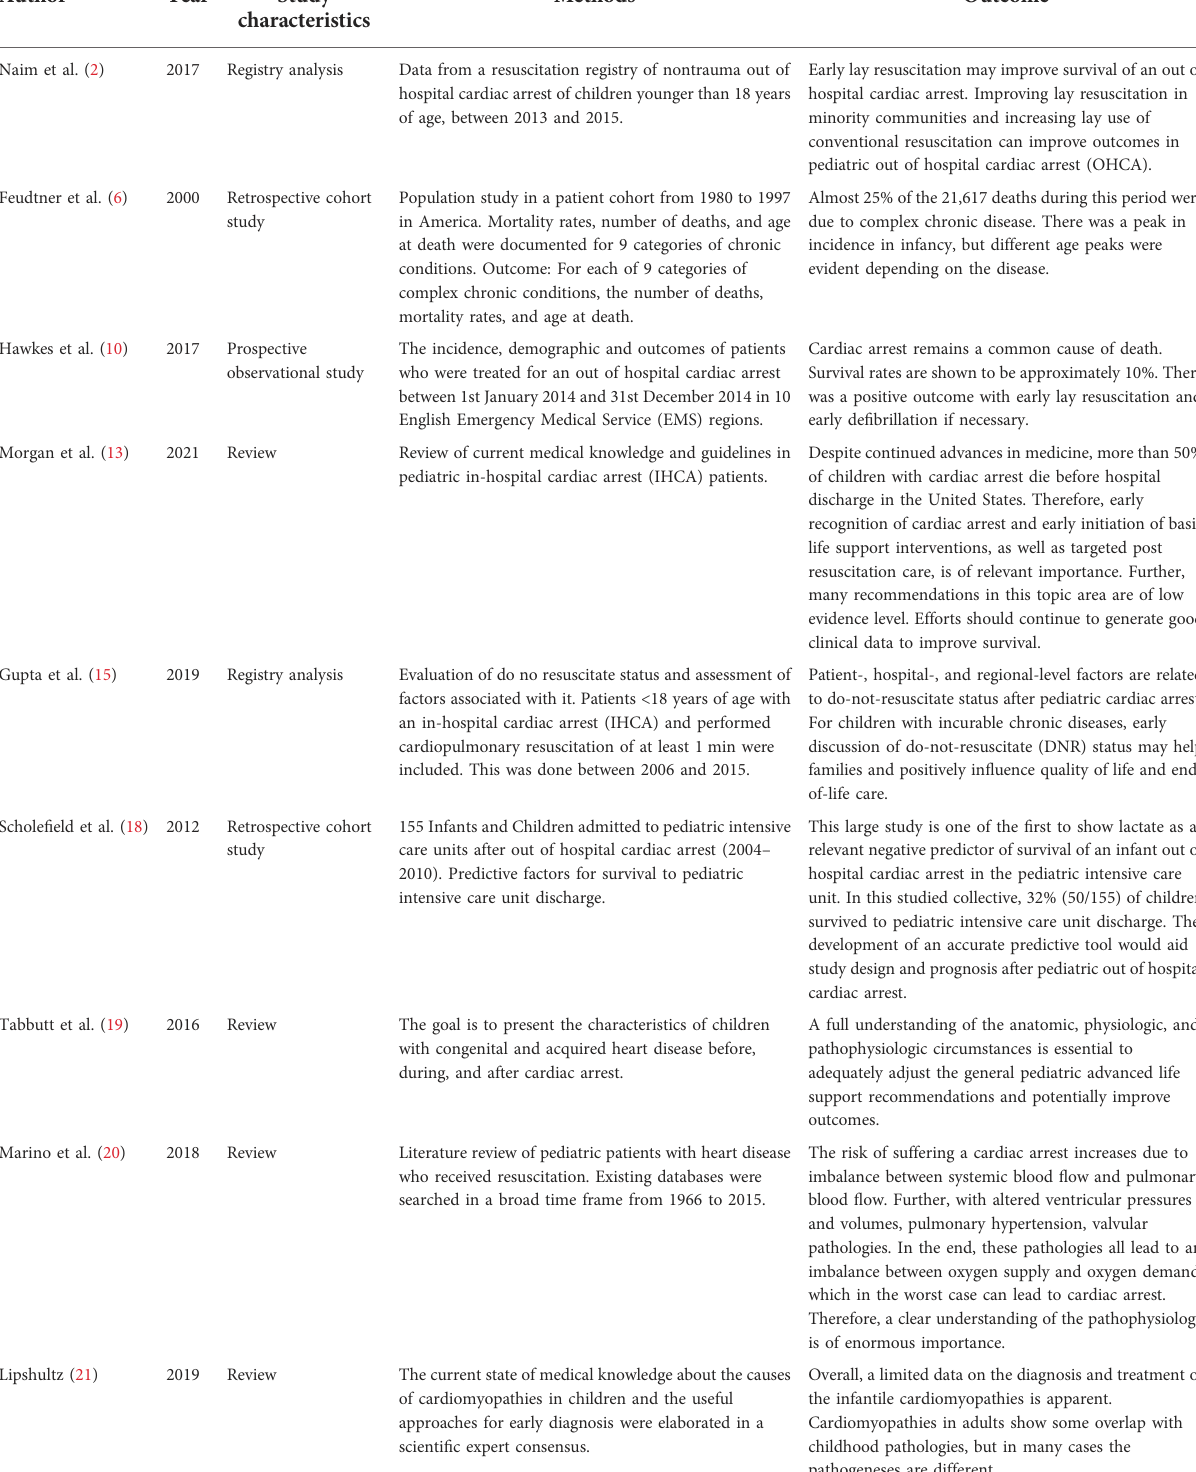
TABLE 1 Overview of essential